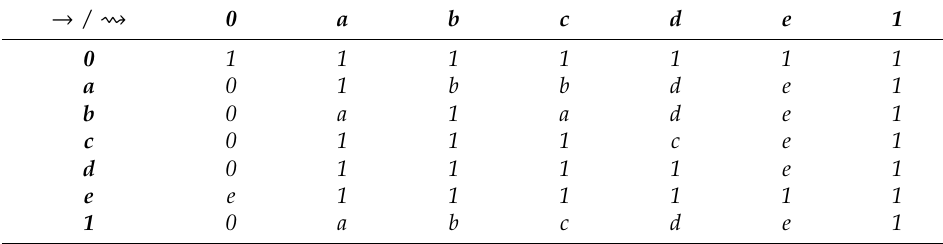
Table 15. The operation → / (cid:32) on X